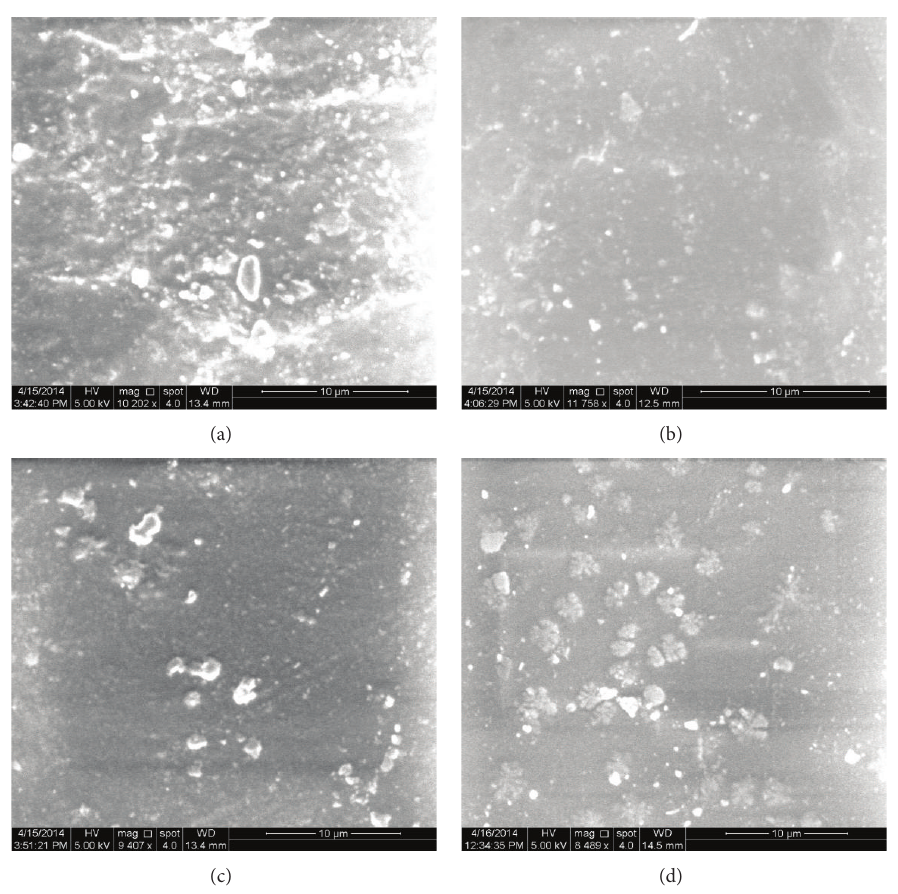
Figure 5: SEM photographs for PVAc/[Co(NH 3 ) 5 Cl]Cl 2 composite films with different concentrations of [Co(NH 3 ) 5 Cl]Cl 2 : (a) 0wt.%, (b) 3 wt.%, (c) 6wt.%, and (d) 9 wt.%.